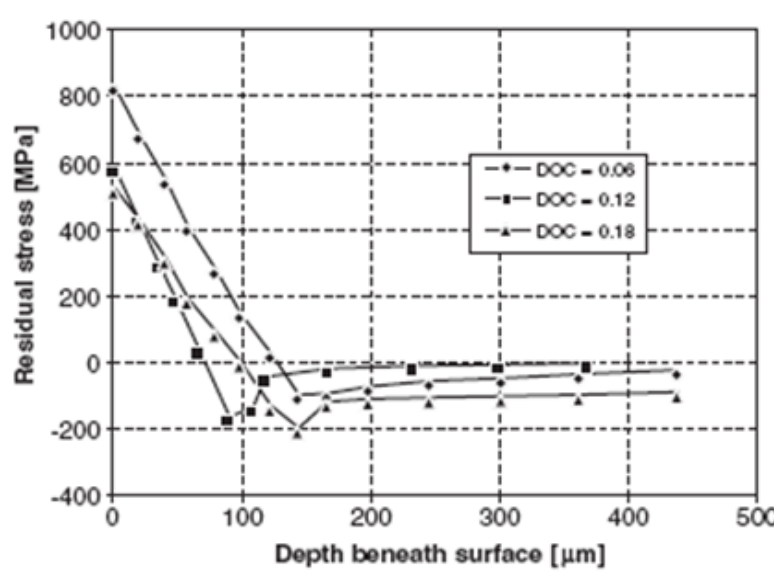
Figure 5: Residual stresses at different depths of